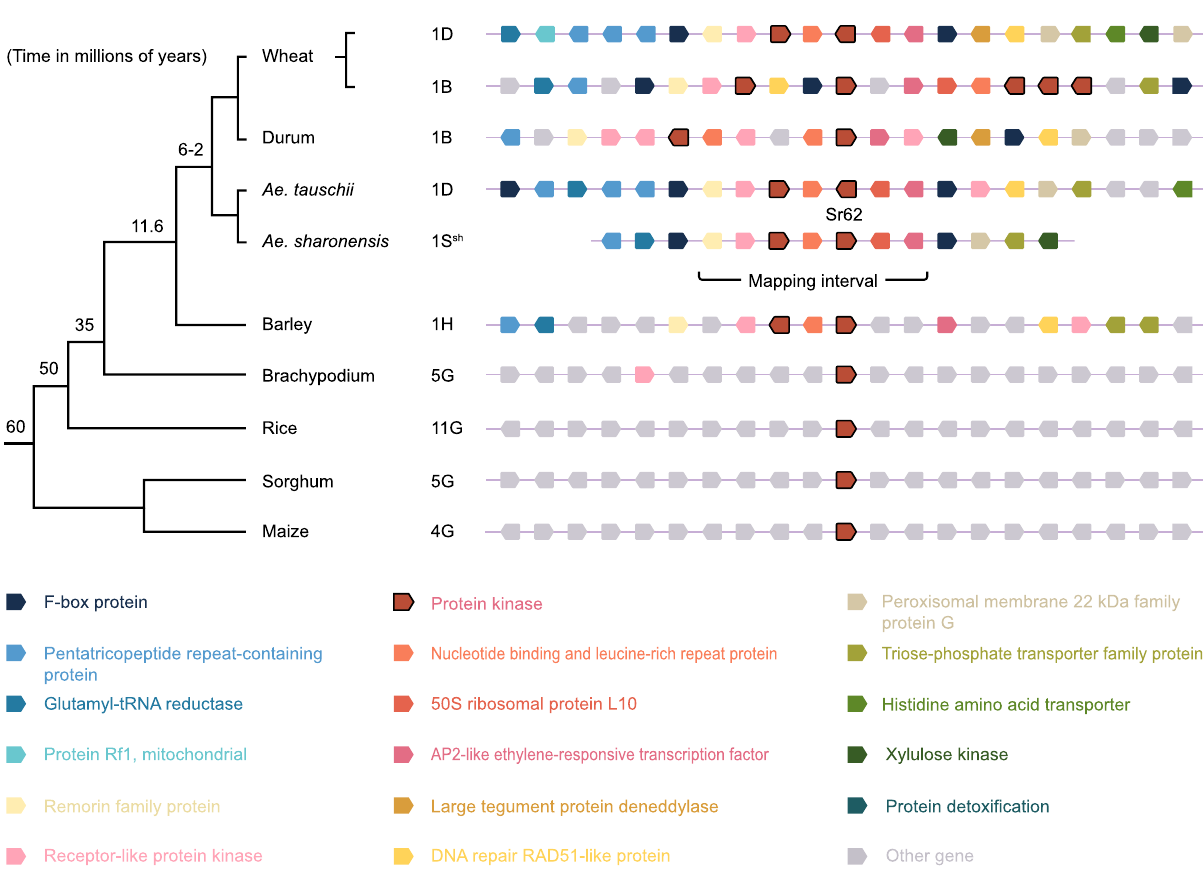
Fig. 5 Synteny around Sr62 . Genomic regions containing genes orthologous to Sr62 along with surrounding genes reveal micro-synteny. The syntenic block is well conserved within the Triticum spp., Aegilops spp., and barley, but appears to be absent from Brachypodium , rice, sorghum and maize. The synteny alignment was generated through Gramene, except for Ae. sharonensis , which was added